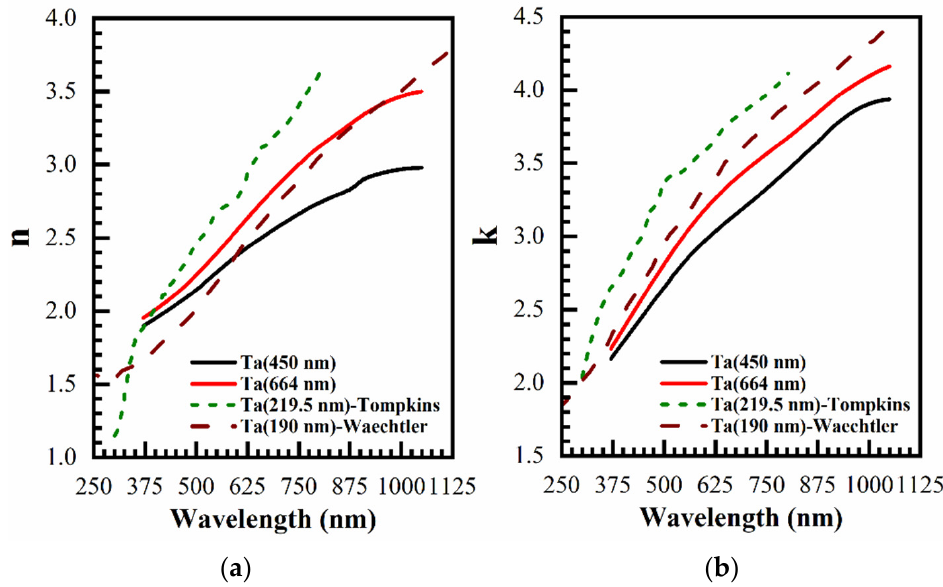
Figure 8. ( a ) Refractive index (n) and ( b ) extinction coefficient (k) of Ta films sputtered for 20 min (450 nm) and 30 min (664 nm) are compared with literature data.